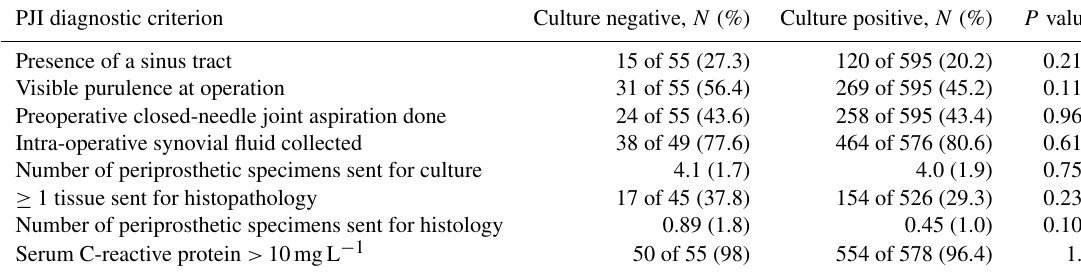
Table 2. Prosthetic joint infection diagnostic criteria.